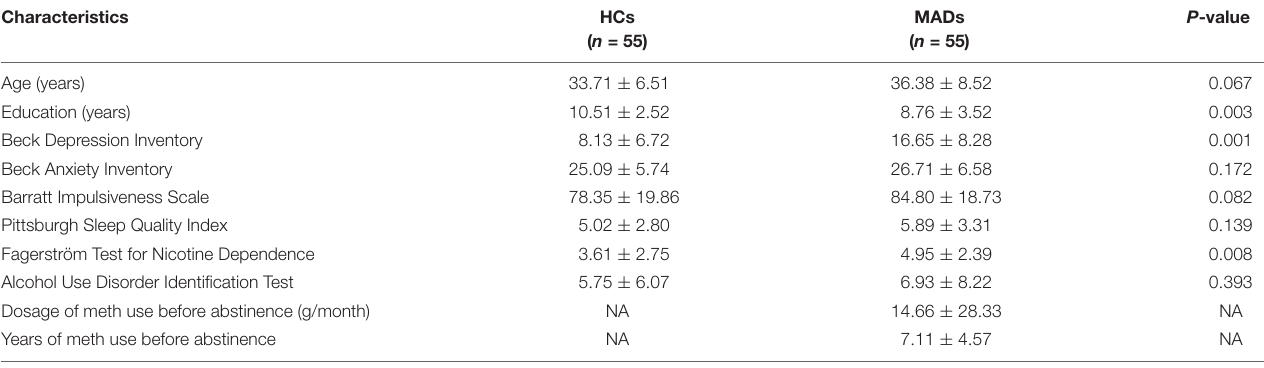
TABLE 3 | Demographic variables of the participants in Experiment 3 (mean ± SD).